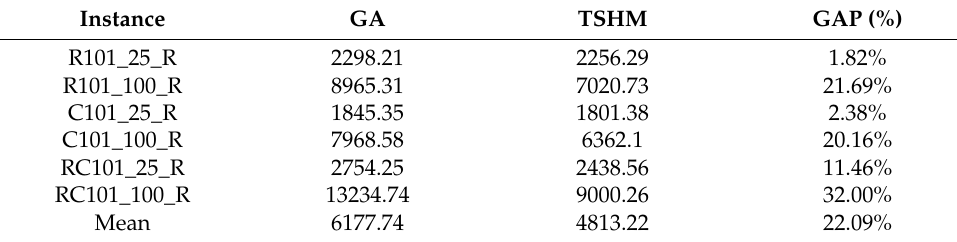
Table 5. Results obtained by GA and